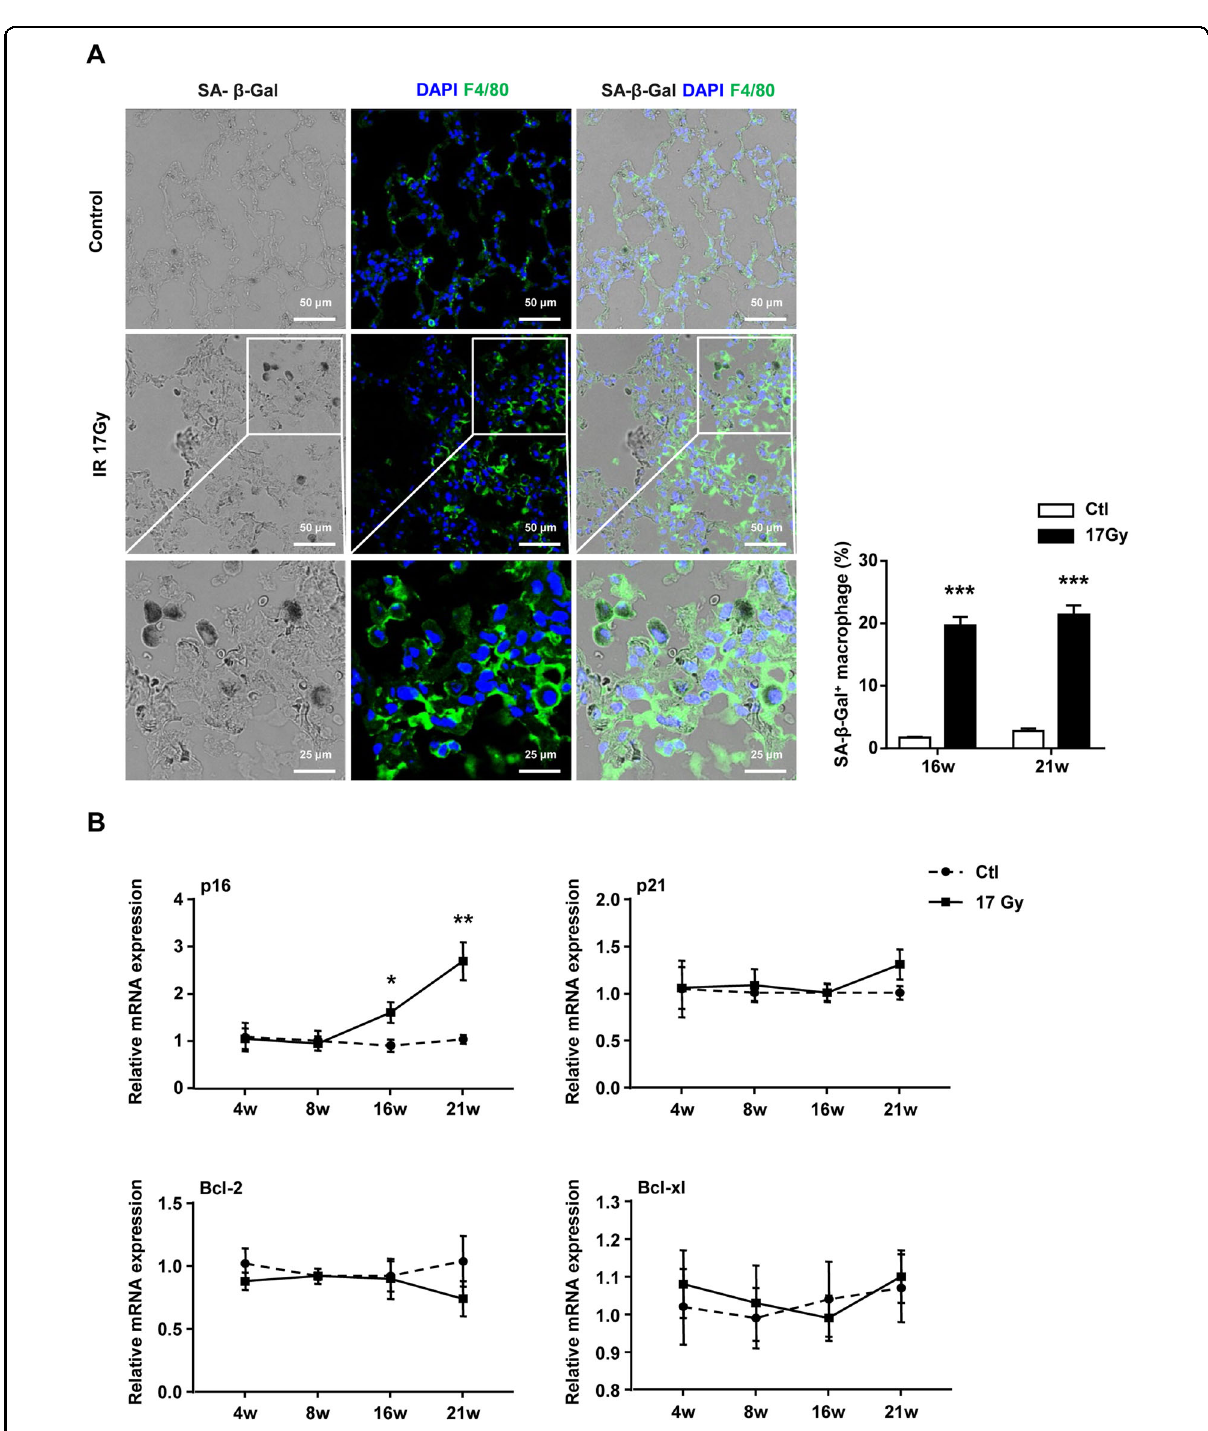
Fig. 4 Pulmonary tissue macrophages had a senescent phenotype after thoracic IR. C57BL/6J mice were exposed to a single dose of 17 Gy IR on the right side of the thorax. Samples of right lung tissue were collected at intervals after IR and in controls. A Representative images of SA- β -gal staining (scale bar, 25 or 50 μ m) and quanti fi cation of SA- β -gal + macrophages in right lung tissue. B qRT – PCR expression of p16, p21, Bcl-2, and Bcl-xl were measured relative to Gapdh levels in sorted populations of macrophages in right lung tissue. Data are expressed as mean ± SEM of six independent experiments, *** P < 0.001, ** P < 0.01, and * P < 0.05 compared with the corresponding